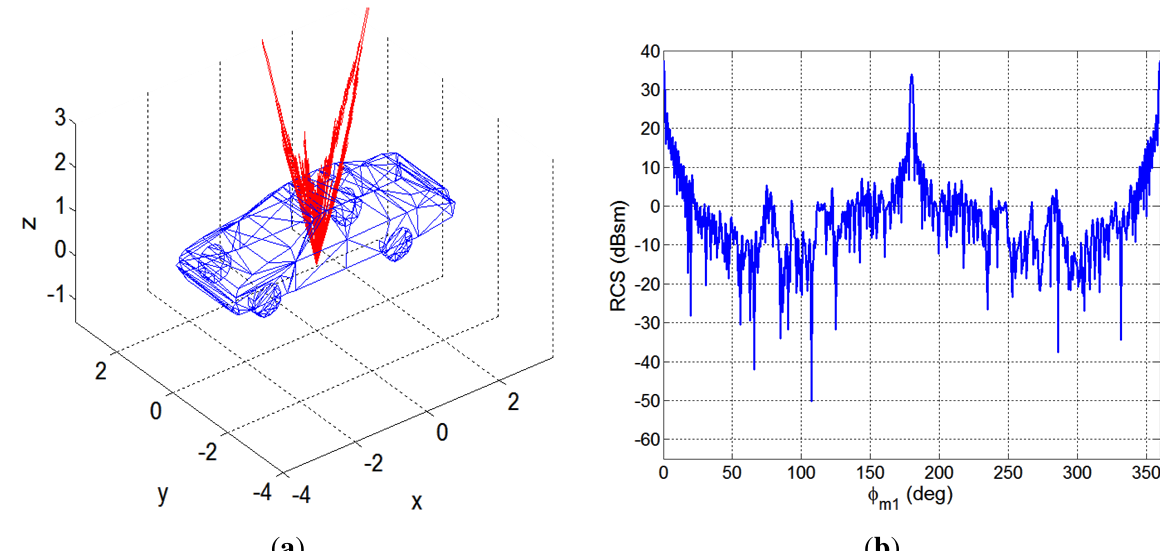
Figure 8. Results obtained for the Monostatic 1 case using POFACETS : ( a ) 3D model of the target and 3D monostatic radar cross-section (RCS); ( b ) Monostatic RCS in Cartesian coordinates.